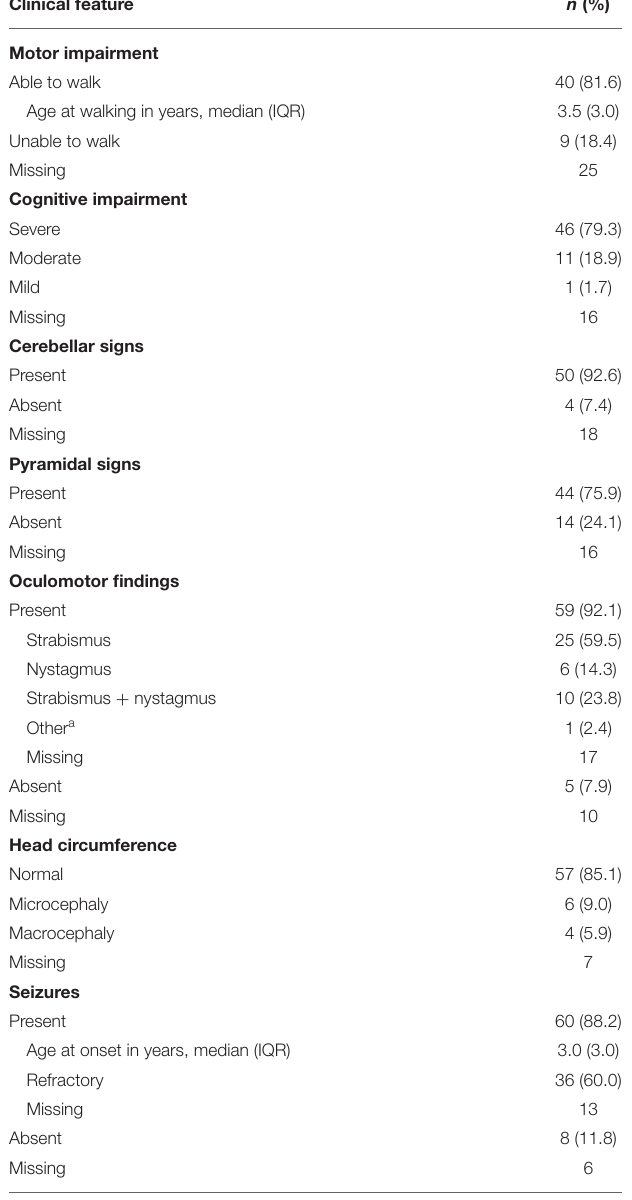
TABLE 1 | Clinical features of reported BFPP cases (2, 3, 8–20). Clinical